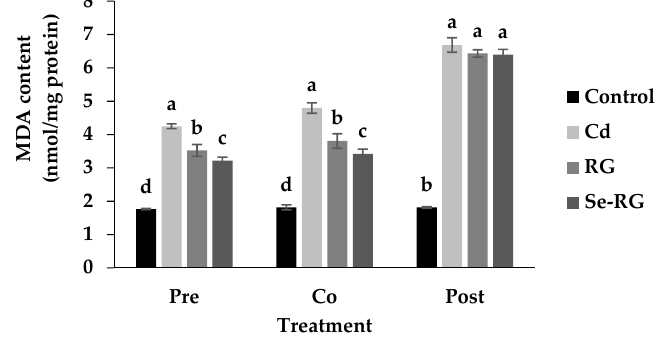
Figure 5. Level of malondialdehyde (MDA) in HEK293 cells treated with RG and Se-RG at the level 10,000 µg / mL compared to the control and Cd-treated ones. Data are means ± standard deviation (SD). Different letters indicated significant differences in the similar group of treatment ( p < 0.05) in Tukey’s significant differences test.